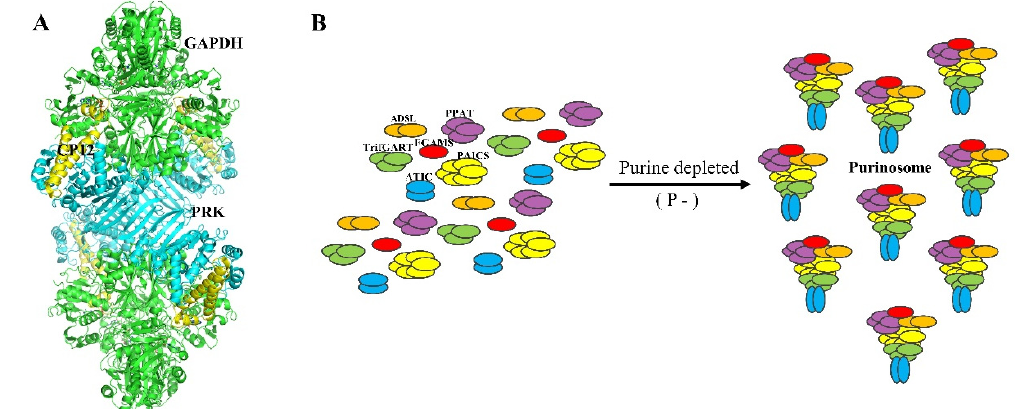
Figure 4. Structure of the GAPDH-CP12-PRK complex and the purinosome formation. ( A ) cryo-EM maps of complexes with GAPDH, CP12 and PRK from Thermosynechococcus vestitus . (resolution 3.90 Å). GAPDH, green; CP12, yellow; PRK, cyan. ( B ) Enzymes of de novo purine biosynthesis assemble into purinosome in purine depleted conditions in Hela cells. PPAT: amidophosphoribosyl transferase, purple; FGAMS: phoshoribosylformylglycinimidine transferase, red; PAICS: bifunctional phosphoribosylaminoimidazole carboxylase and phosphoribosyl aminoimidazole (CAIR synthetase, and SAICAR synthetase), yellow; ATIC: bifunctional 5-aminoimidazole-4-carboxamide nucleotide formyltransferase/IMP cyclohydroxylase (IMPCH), blue; ADSL: bifunctional adenylosuccinate lyase, orange; GART: trifunctional phosphoribosylglycinamide formyltransferase (GAR synthetase, GAR formyltransferase, and AIR synthetase), green.